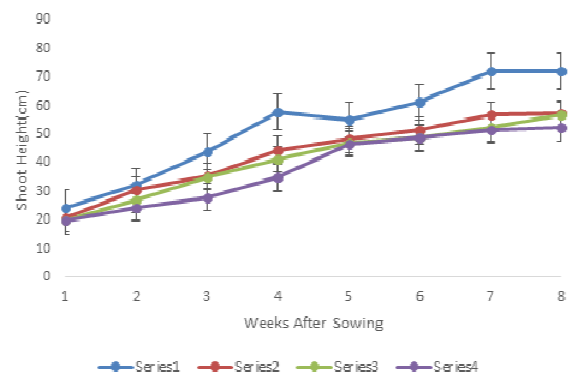
Fig. 1. The effect of Magnesium application on the shoot height of C. olitorius grown under different levels of nutrient solution